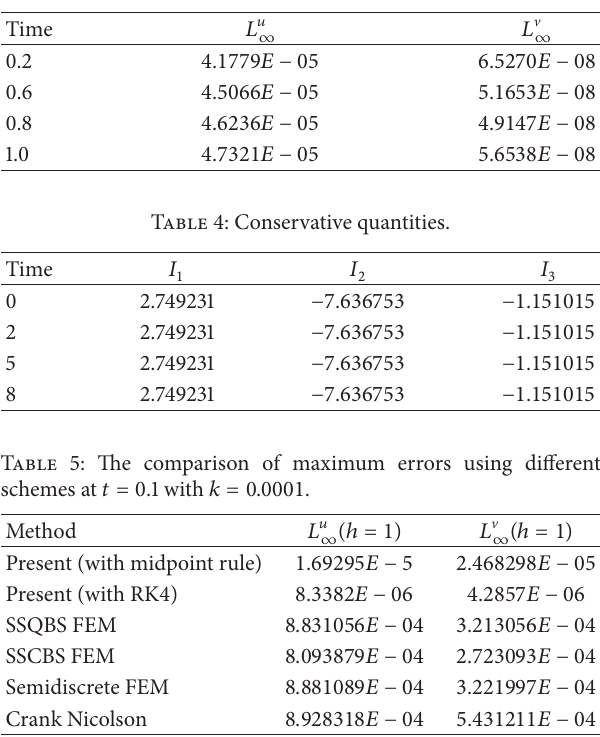
Table 3: Errors using Runge-Kutta method.